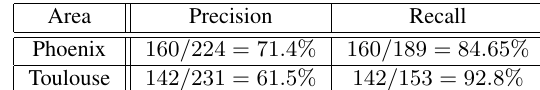
Table 1: Performance of our algorithm on the two selected areas around